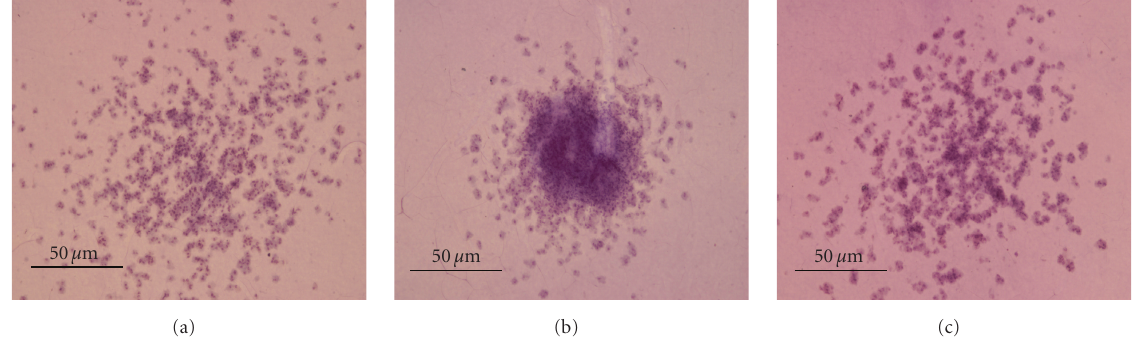
Figure 8: E ff ect of rSj16 on morphology of M-CSF-induced CFU-M colonies after hematoxylin staining. Mouse bone marrow cells were treated with M-CSF in the presence of rSj16 (b), rGST (c ) , or PBS (a) as described in Figure 7. The black bars represent 50 μ m (magnification, × 100). The photos are representatives of three individual